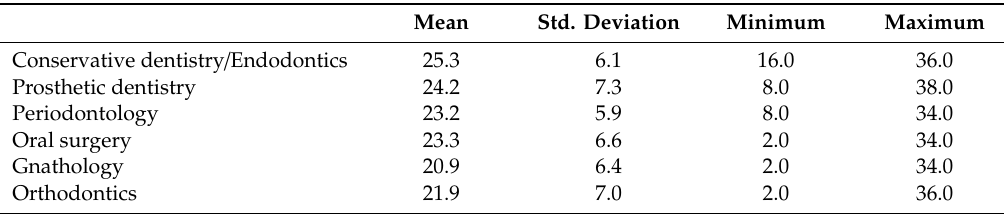
Table 1. Final score according to clinician’s